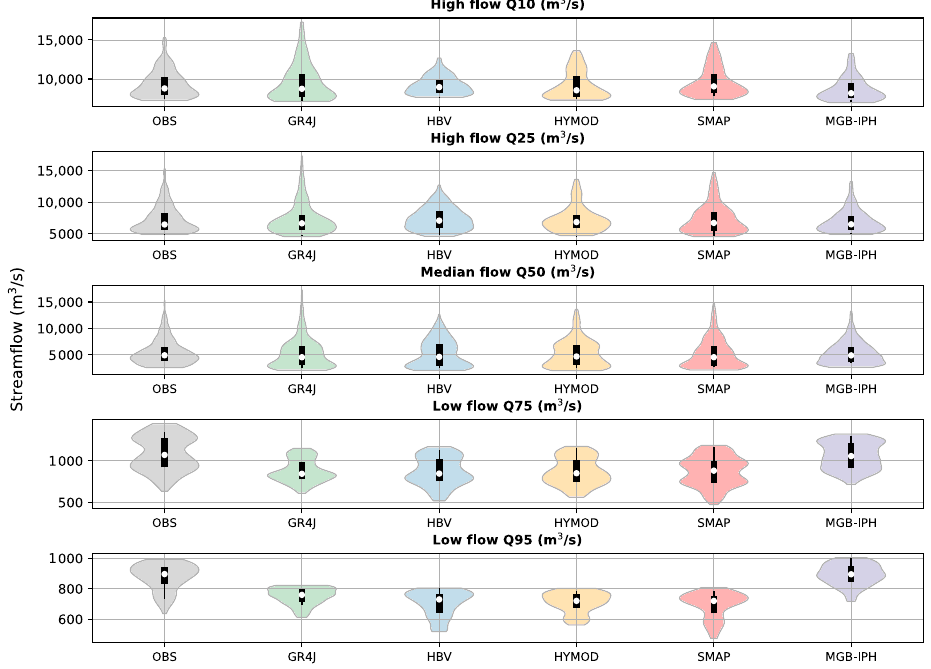
Figure 14. Violin plot describing the low, median, and high flows simulated in the Tocantins river basin by multiple hydrological models. Validation